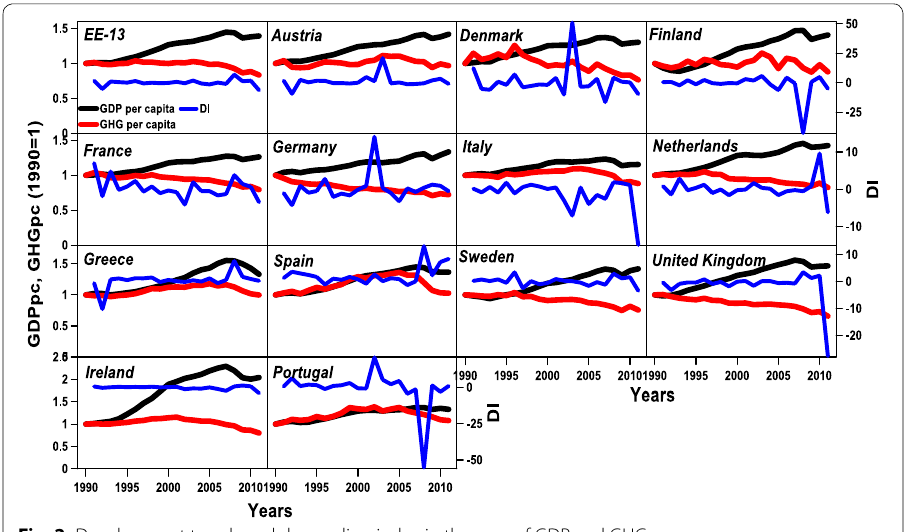
Fig. 2 Development trends and decoupling index in the case of GDP and